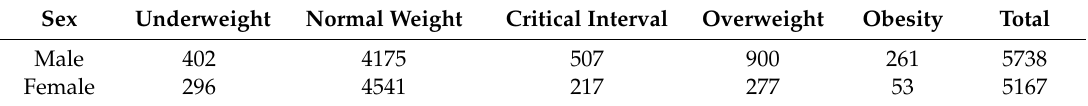
Table 2. Data records by Body Mass Index (BMI) categories and sex. Underweight corresponds to BMI less than 17.8 for males and less than 17.1 for females. Normal weight corresponds to BMI between 17.9 and 23.9 for males and between 17.2 and 23.0 for females. For both sexes, overweight corresponds to BMI between 24.0 and 27.9, with BMI greater than 28.0 for obesity. The critical interval is BMI between 22.9 and 23.9, in which transition from normal weight into overweight is more